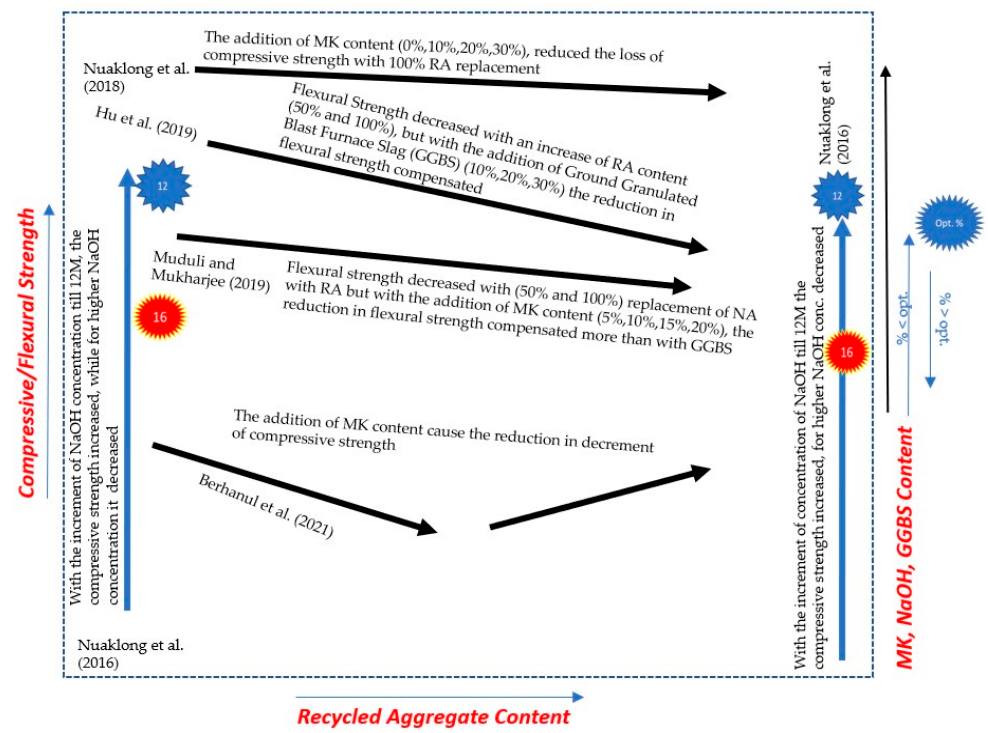
Figure 6. General overview of previous research on GRAC